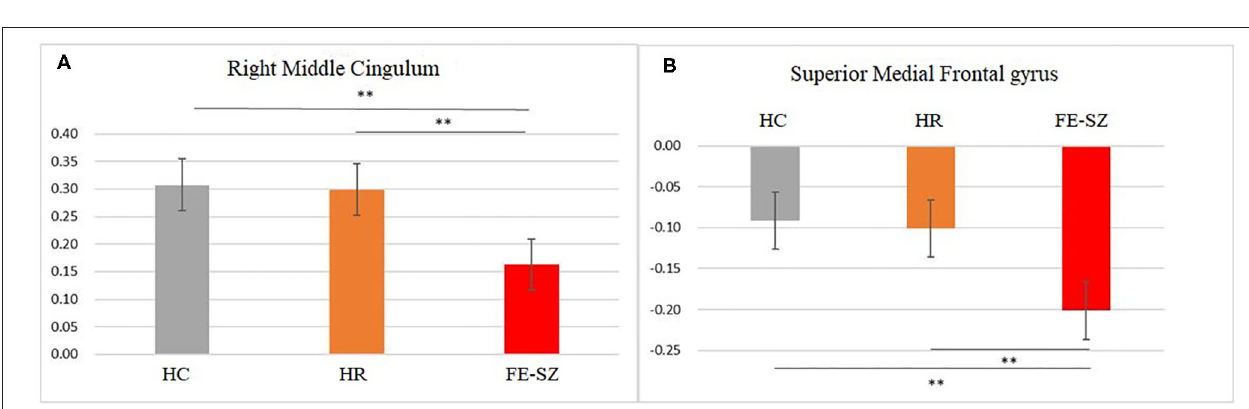
FIGURE 2 | Post hoc results of amygdala (A) and hippocampus (B) functional connectivity. **Bonferroni corrected, p <